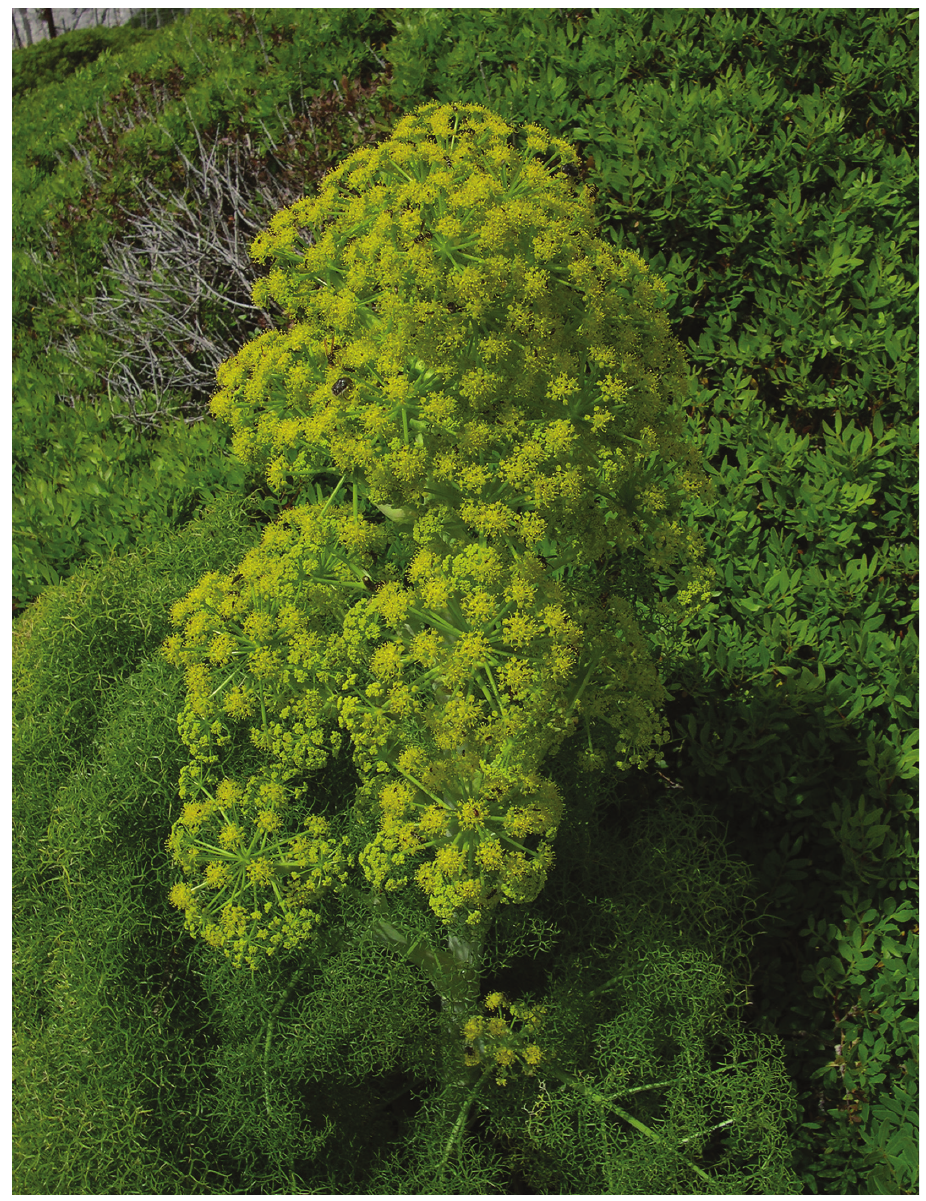
Figure 5. Ferula arrigonii Bocchieri in its locus classicus on Isola di Serpentara (Sardinia). Photograph by G.